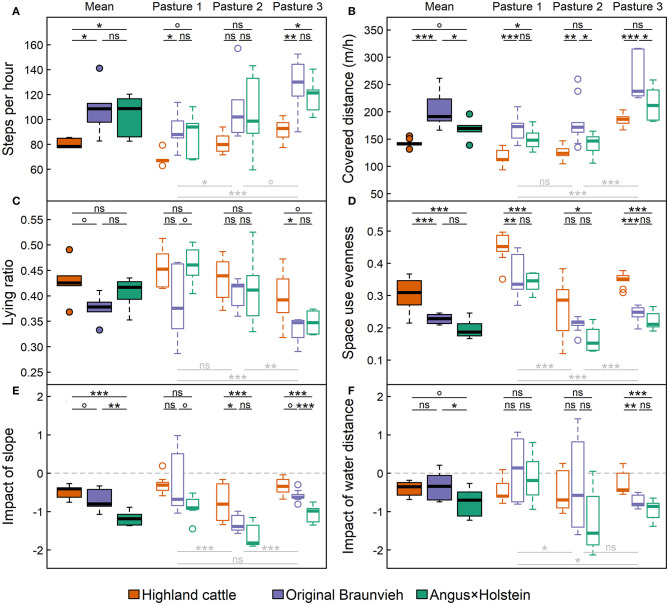
Movement behavior of the three breeds Angus × Holstein, Original Braunvieh, and Highland cattle: (A) The average number of steps recorded per hour; (B) the average covered distance per hour (i.e., the speed); (C) the ratio of the time spent lying; (D) the evenness of space use; (E) the impact of slope, and (F) of the distance to water points on cattle movement behavior. Steps and lying ratio were recorded for six, covered distance and space use evenness for all nine cows per breed. Filled boxplots represent mean values, empty boxplots differentiate by the three types of alpine pastures: (1) nutrient-rich, flat pasture, (2) heterogeneous dwarf-shrub pasture, (3) nutrient-poor fen and wood pasture. Significances of differences among breeds are displayed above the boxplots in black, those among pastures below the boxplots in light gray [box: 25th to 75th quartile range (IRQ); line: median; whiskers: max. 1.5 × IQR; points: outliers; nsp > 0.1; °p < 0.1; *p < 0.05; **p < 0.01; ***p < 0.001].